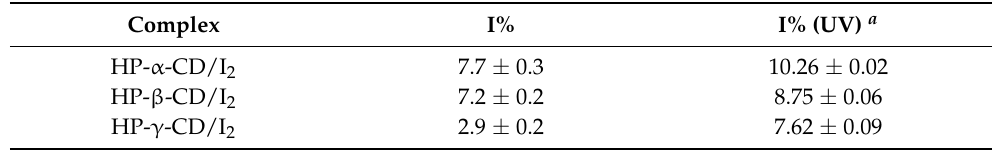
Table 3. Iodine % determination by EDX analysis.